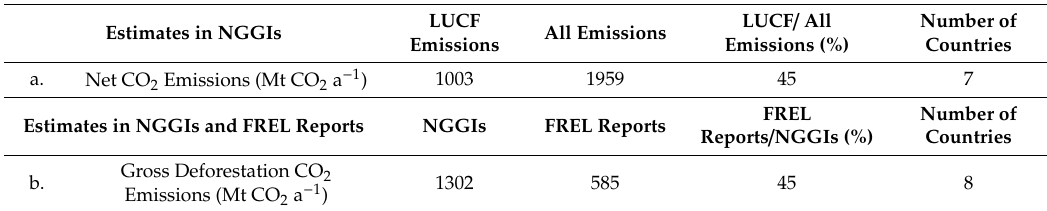
Table 5. Aggregate emissions in the 2000s of carbon dioxide (CO 2 ) from the Land Use Change and Forestry (LUCF) sector, all national sectors, and deforestation only, reported in the National Greenhouse Gas Inventories (NGGIs) and Forest Reference Emission Level (FREL) reports of two groups of countries